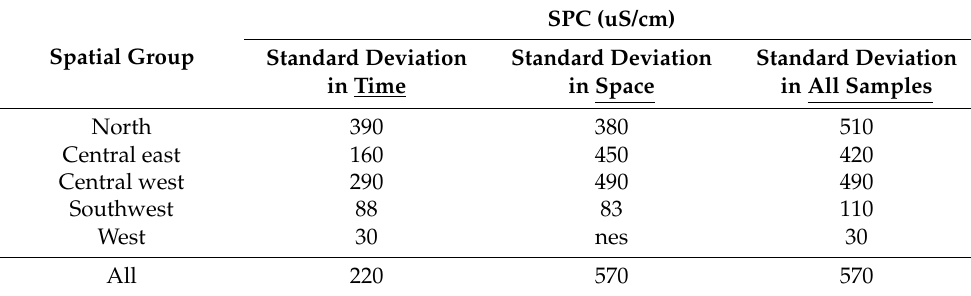
Table 5. Standard sample deviations by spatial group and for the entire study region in SPC ( µ S/cm) for Dockum samples only. Standard deviations are organized according to the instances when the location is kept the same and the time is changing (same well location, different sample events) and when the time is kept the same and the location is changing (same sample event, different well locations). SPC (uS/cm) Spatial Group Standard Deviation Standard Deviation Standard Deviation in Time in Space in All